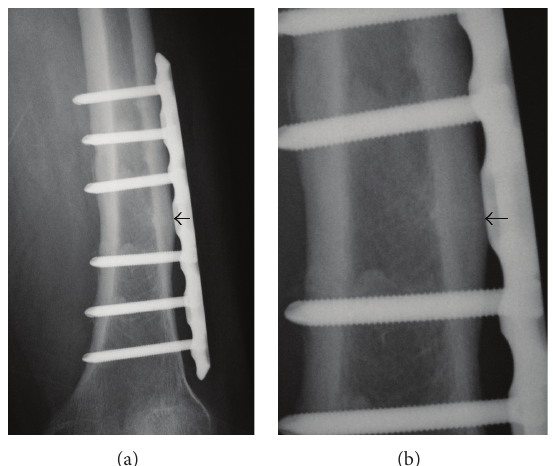
Figure 3: Anteroposterior radiographs of the left femur 3 months after surgical treatment. (b) is a magnified view of (a). The horizontal line over the outer cortical bone (black arrows) had almost disappeared.